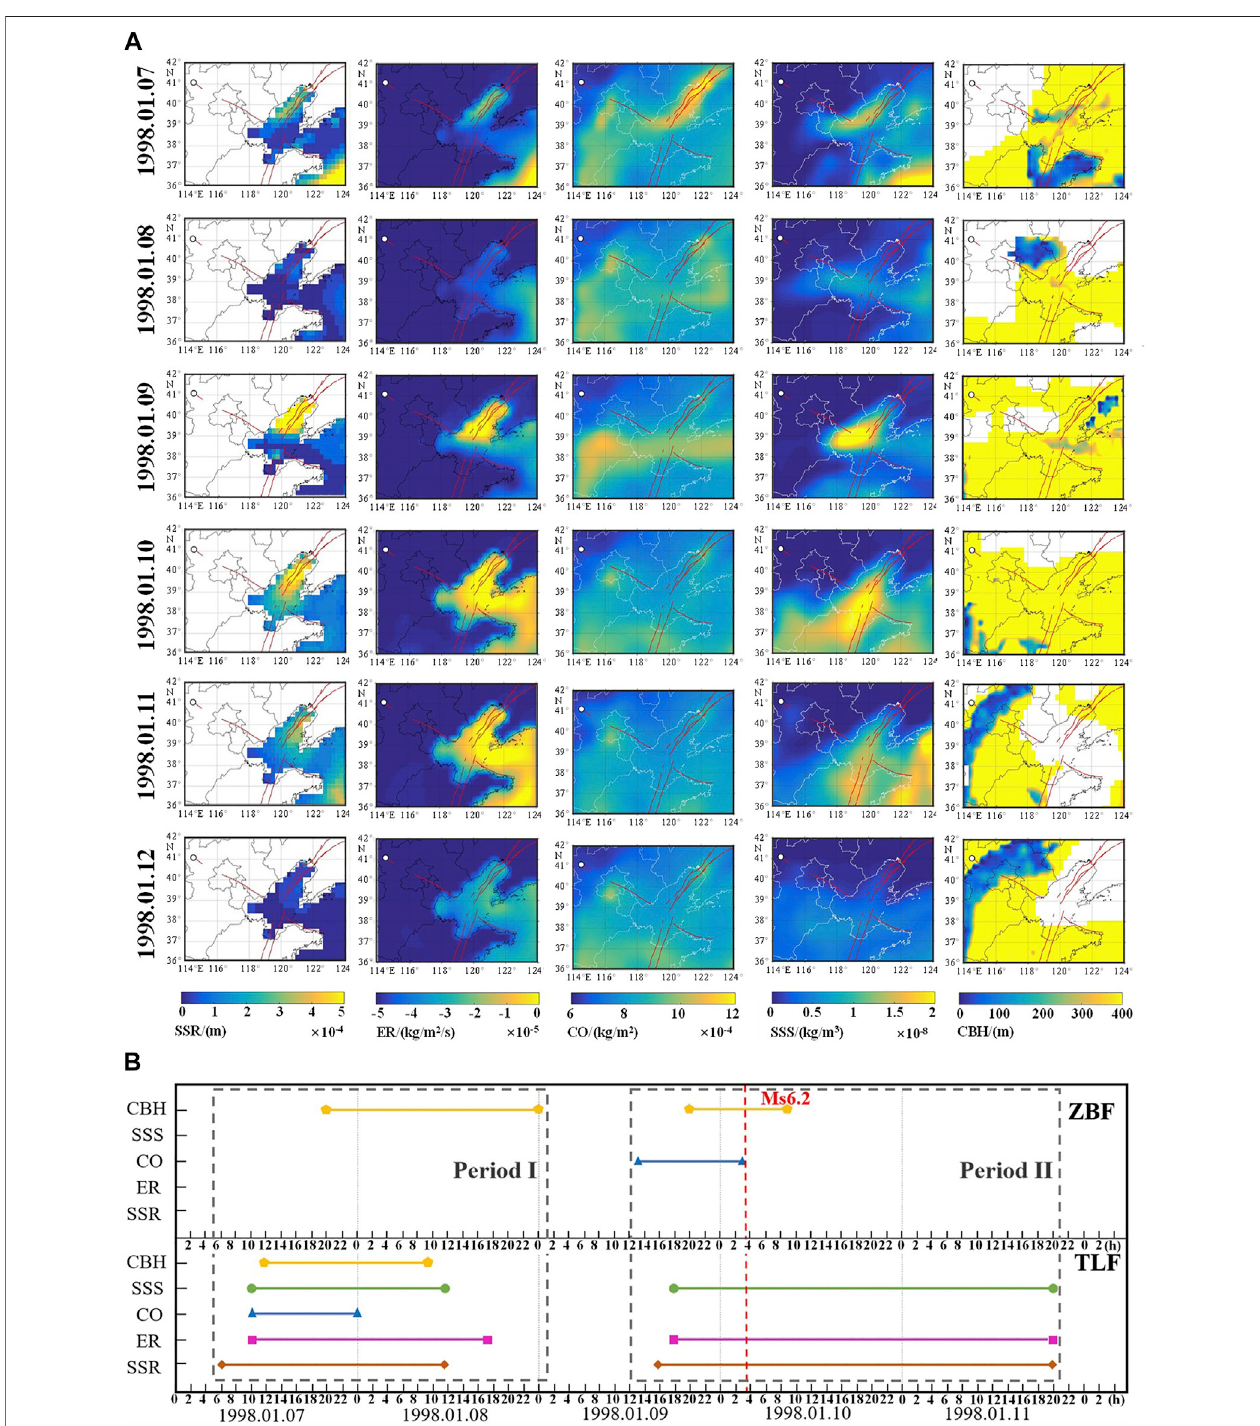
FIGURE 9 | The spatial (A) and temporal (B) change of atmospheric anomalies over Bohai Sea.